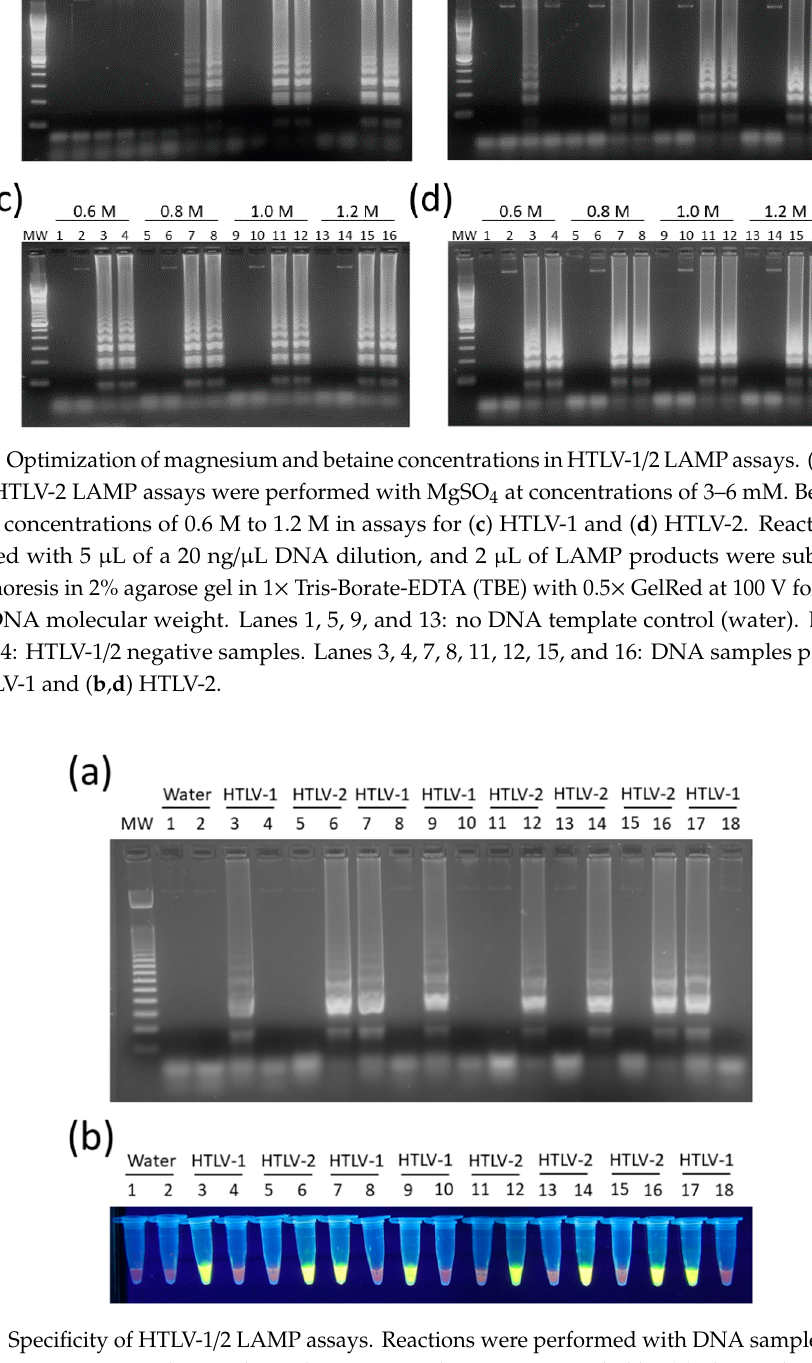
Figure 4. Specificity of HTLV-1/2 LAMP assays. Reactions were performed with DNA samples positive for HTLV-1 or HTLV-2, where indicated. LAMP products were revealed by ( a ) electrophoresis in 2% agarose gel in 1× TBE with 0.5× GelRed, and ( b ) with SYBR TM Green I added to tubes to a 100× final concentration. MW, 100-bp DNA molecular weight; Water, no template control; LAMP assays specific for HTLV-1 (odd lanes) or HTLV-2 (even lanes).